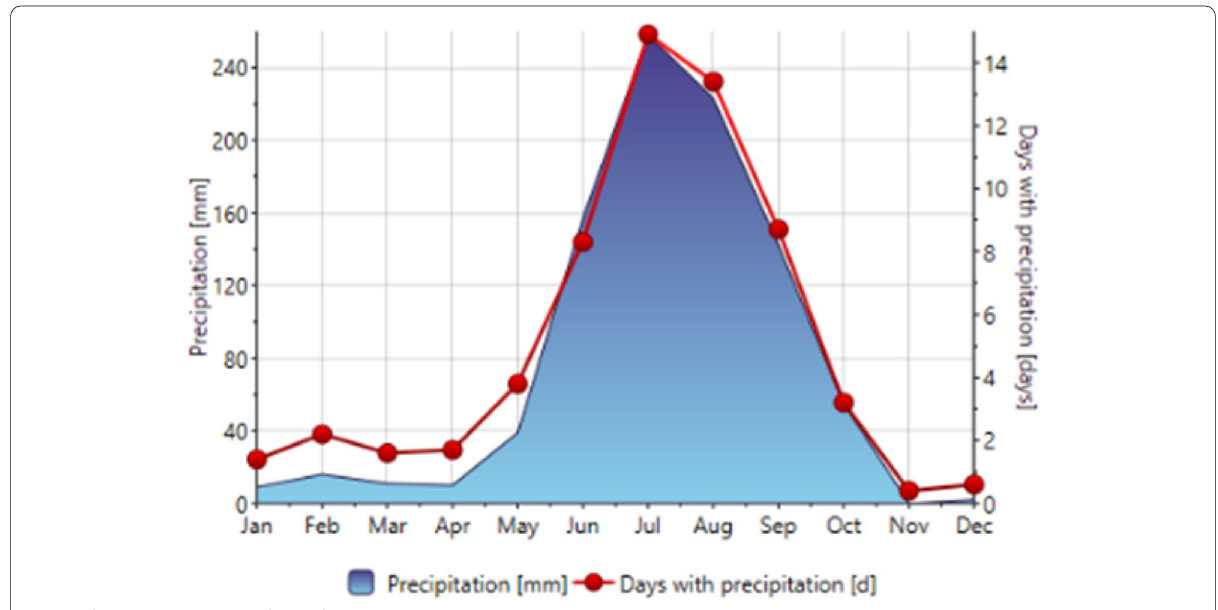
Fig. 7 The precipitation in